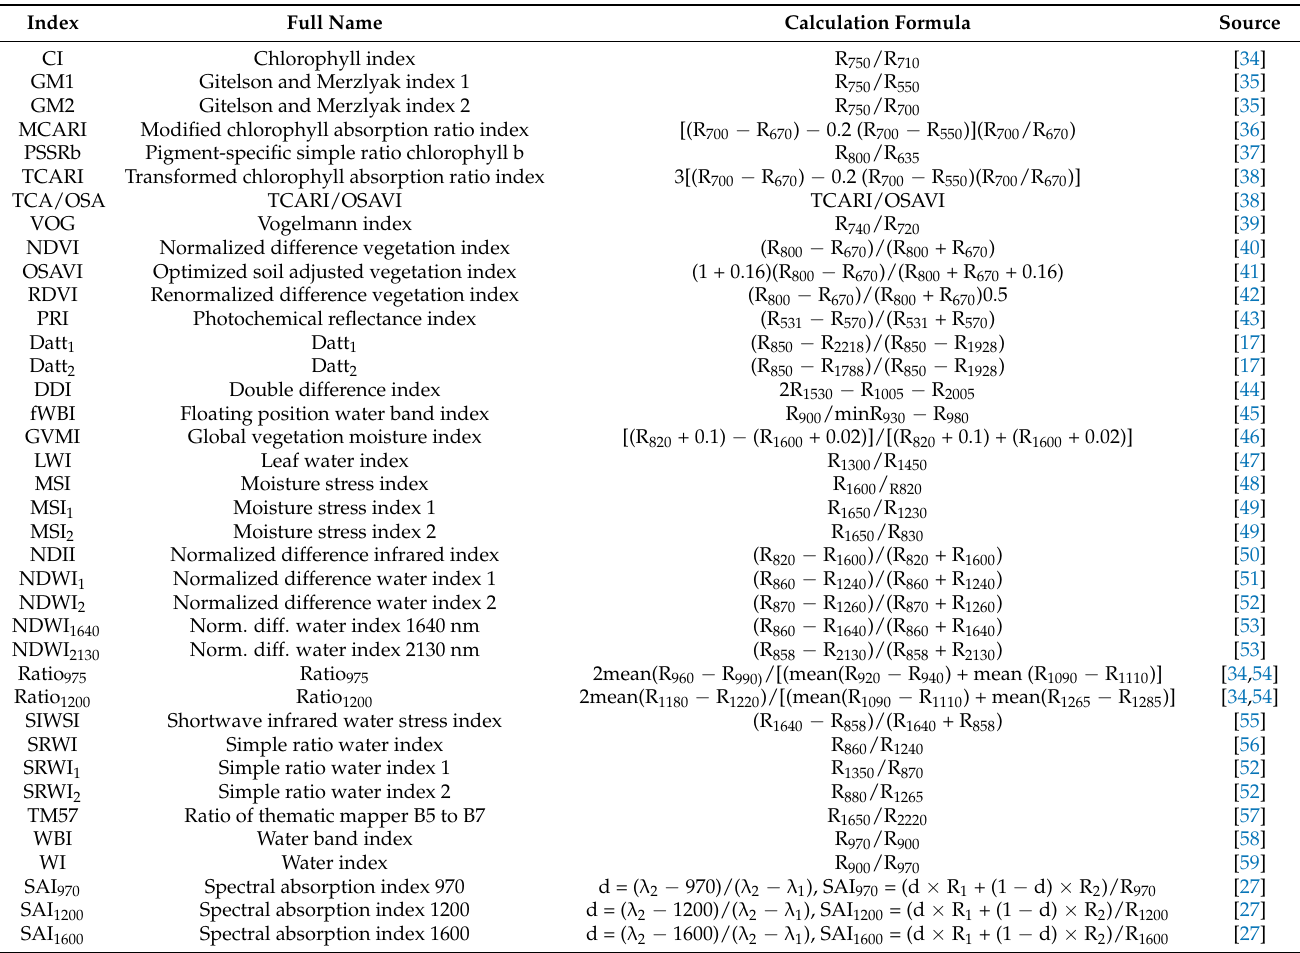
Table 1. Indices included in the